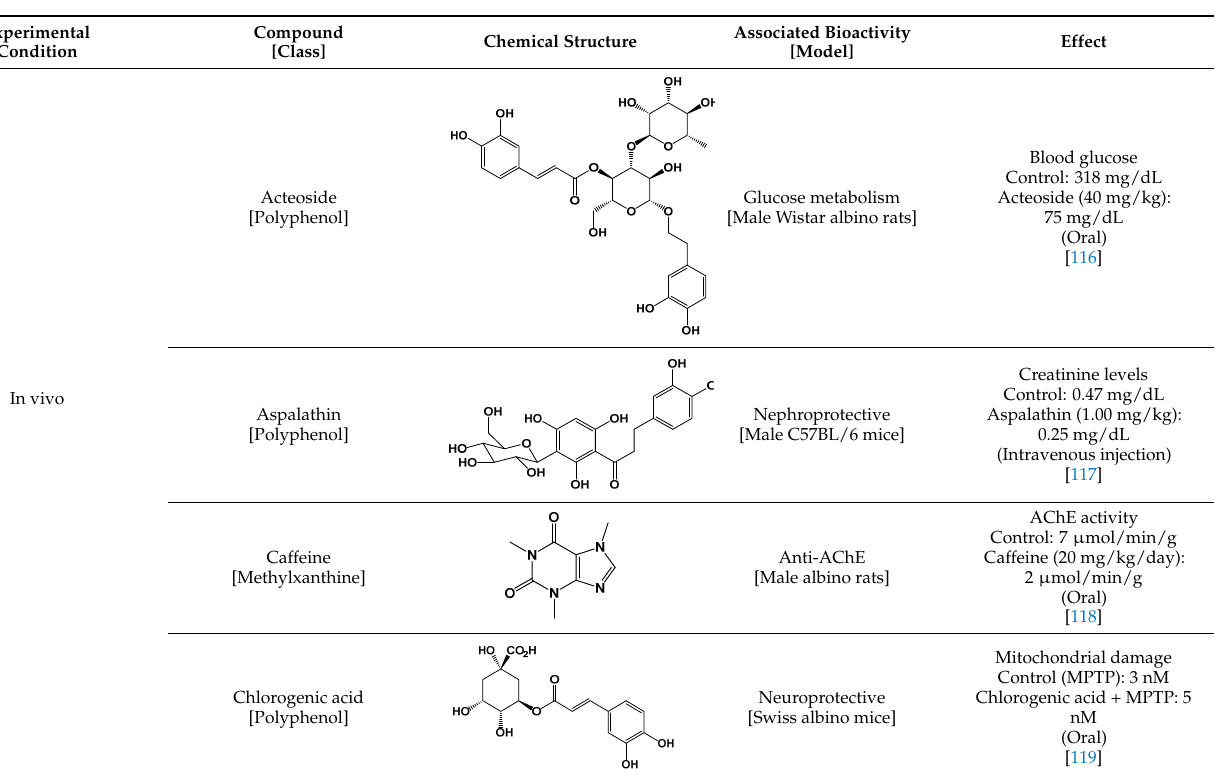
Table 2. Biomarkers related to oxidative stress, glycoxidation, and neurodegeneration. Physiological Target